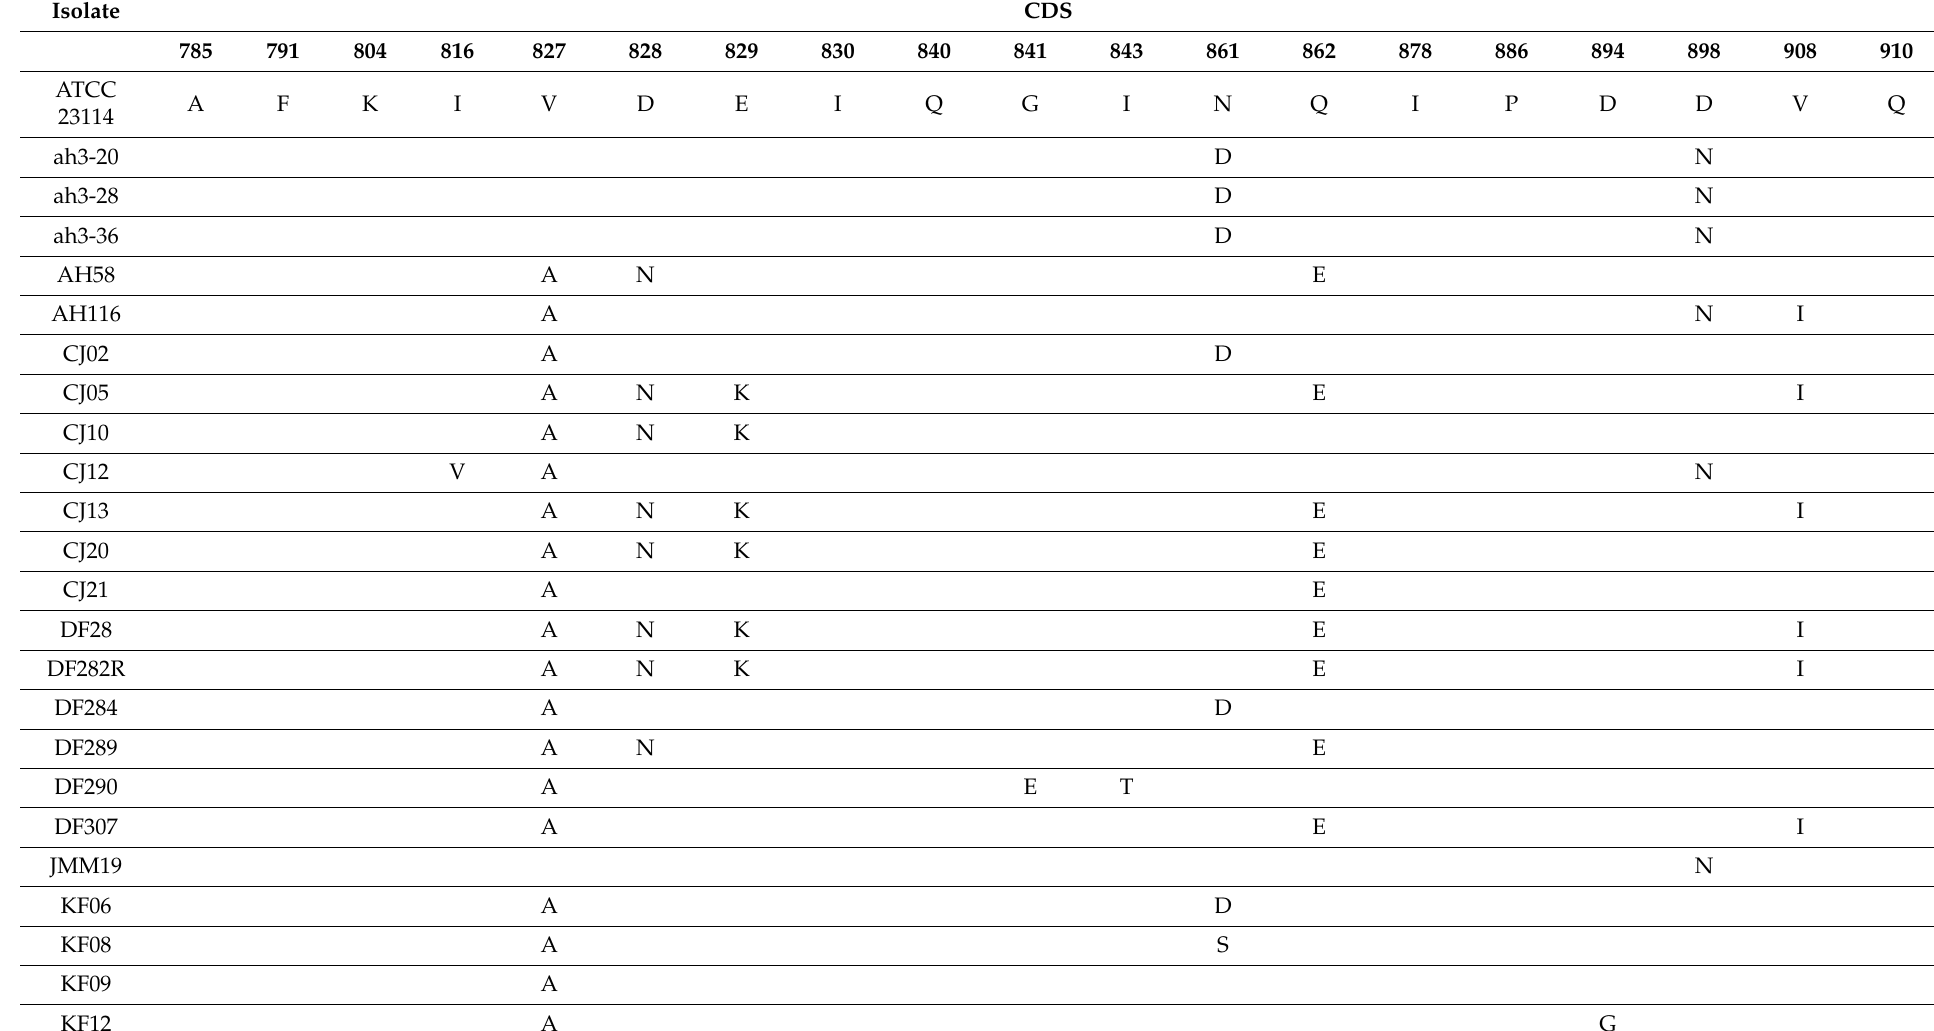
Table A5. Amino acid variations present in the parC genes of all isolates analyzed in reference to ATCC